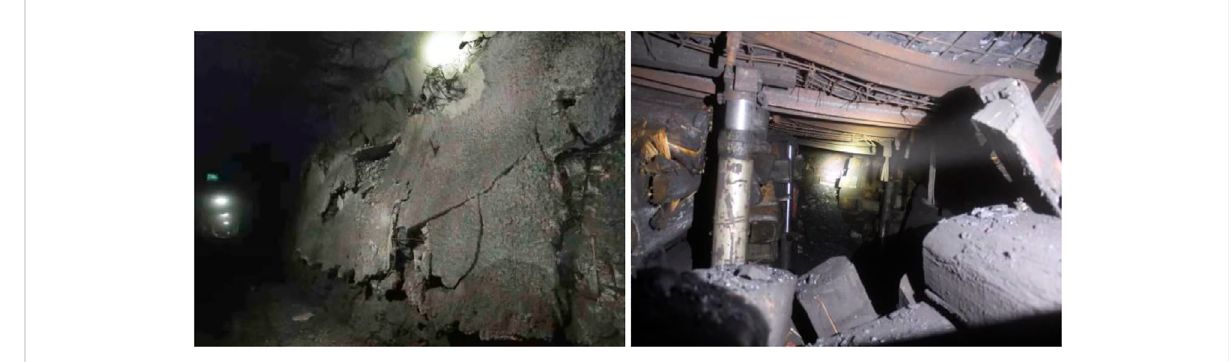
FIGURE 1 Deformation of strong dynamic pressure roadway in the Datong mining